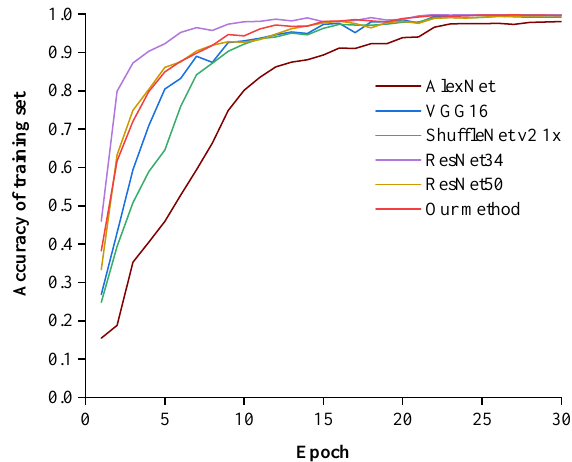
Figure 11. Comparison of accuracy of each model training set.